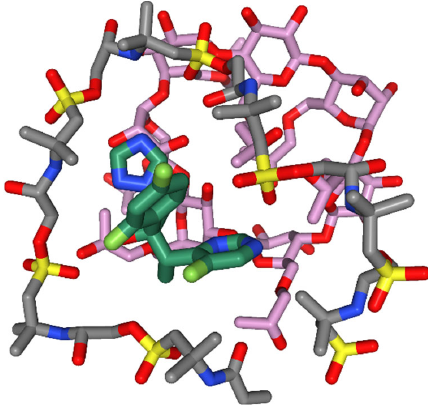
Figure 11. The CDN5 complex as obtained from molecular modelling. The VRC is presented as balls and sticks, while AMPS and HP β CD are shown as molecular surfaces. The visual was rendered using NGL viewer.